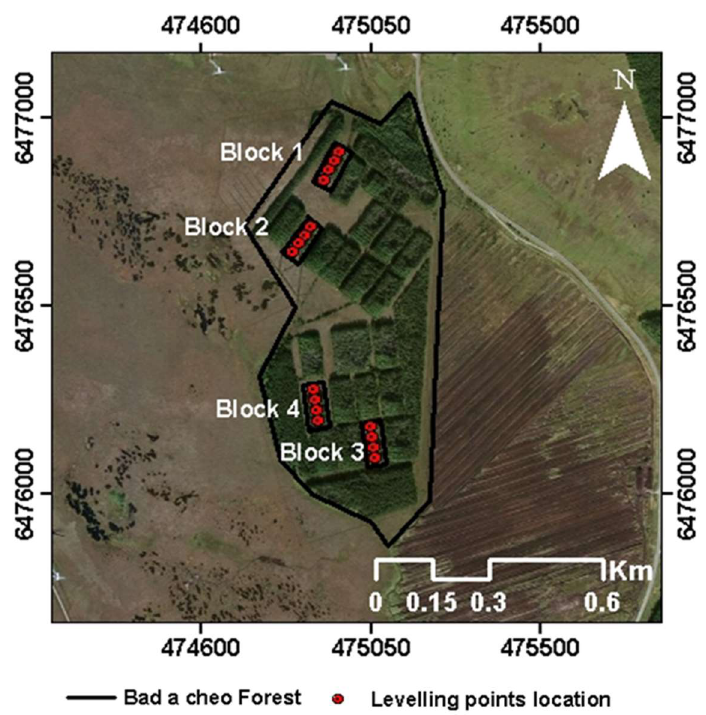
Figure 2. A very high resolution RGB image of the UK Forestry Commission’s Bad a’ Cheo Forest Research Reserve (outlined in black, centered on 475066 E, 6476417 N (WGS-1984-UTM-Zone-30N)) showing the mid-point locations of the levelling transects from which the levelling measurements were taken (red dots). Note there are four forest blocks, each with four levelling measurements transects. In the quantitative assessment of the InSAR surface velocity outputs, these levelling measurements are used for comparison and context.